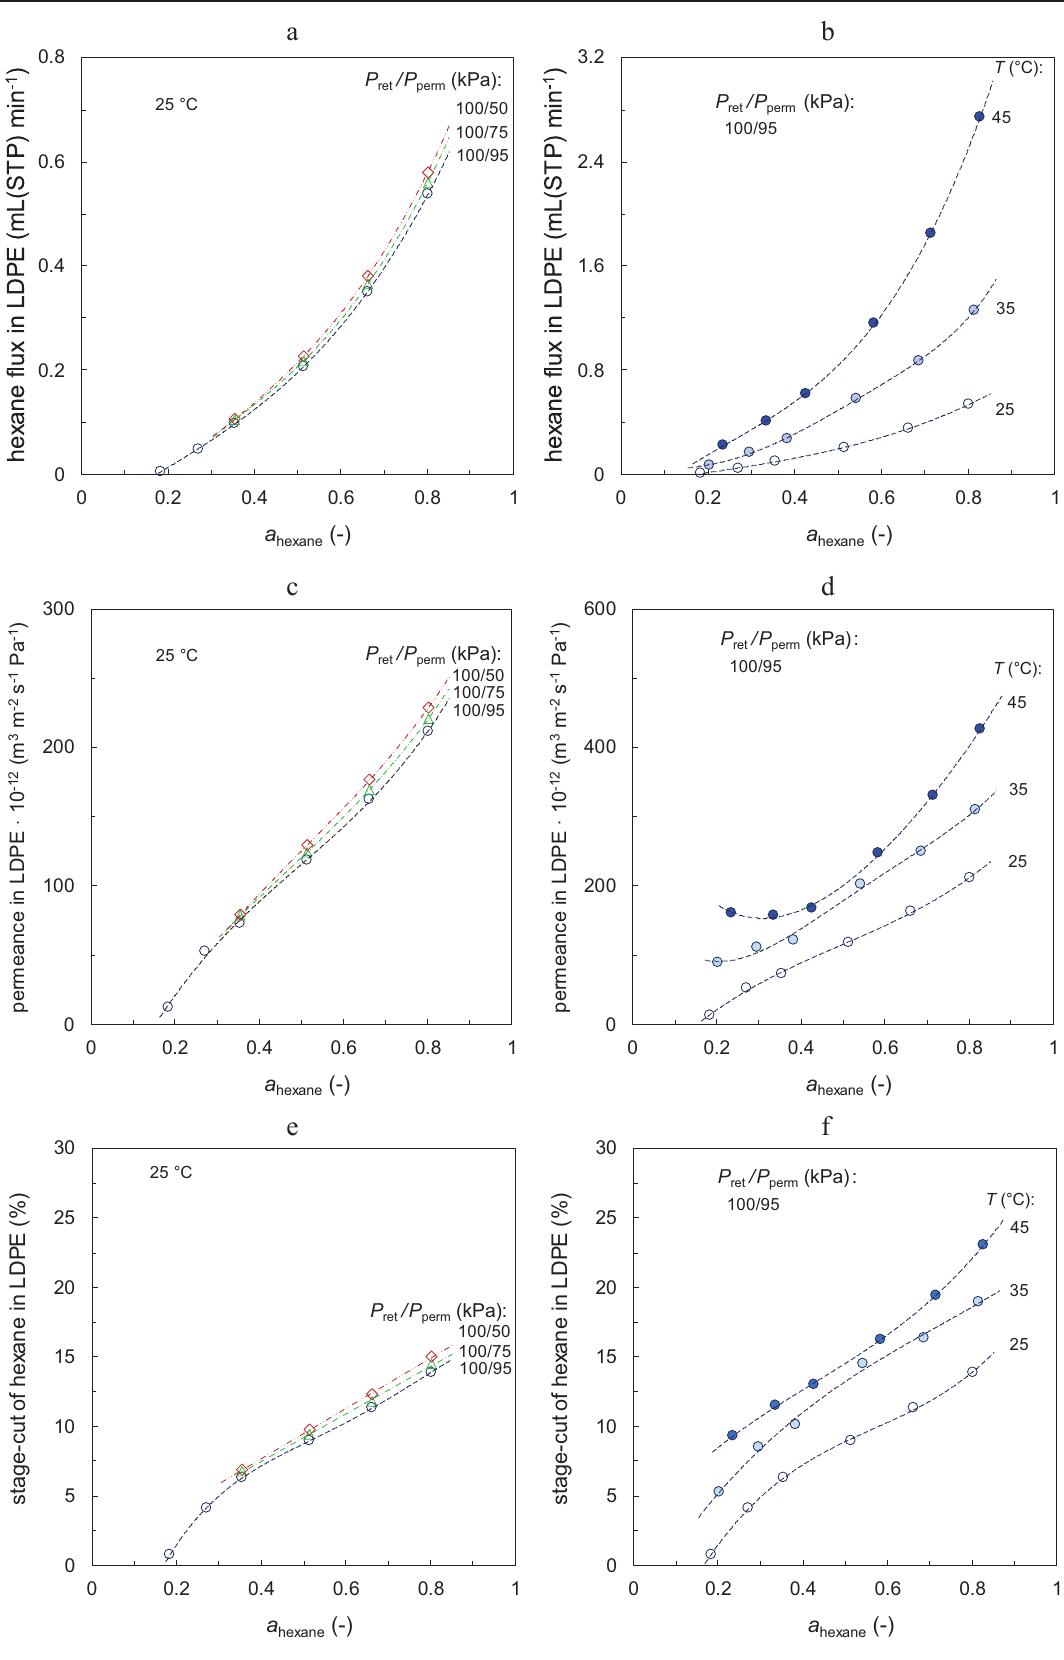
Fig. 3 – Results of permeation experiments with LDPE membrane: a, b) Hexane flux as a function of the hexane activity, tempera - ture and trans-membrane pressure; c, d) Hexane permeance as a function of the hexane activity, temperature and trans-membrane pressure; e, f) Hexane stage-cut as a function of the hexane activity, temperature and trans-membrane pressure; The lines are intend - ed as a guide to the eye.